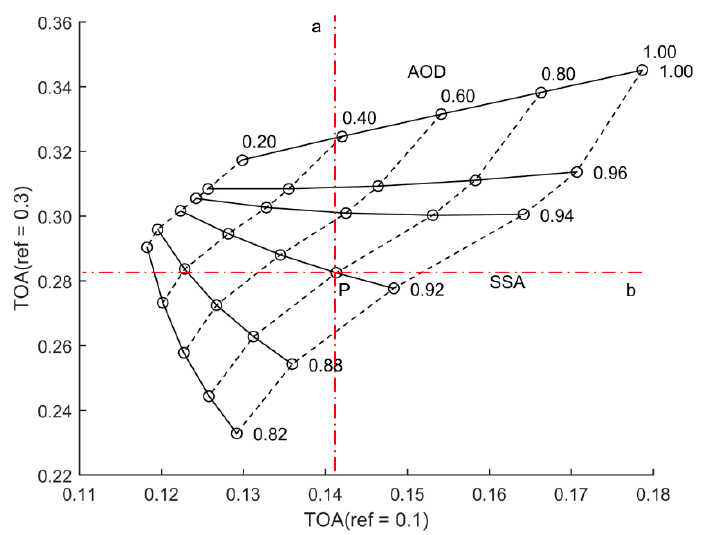
Figure 4. Simulation of TOA reflectance (surface reflectance = 0.3) vs. TOA reflectance (surface reflectance = 0.1) for different SSA and AOD setting pairs.